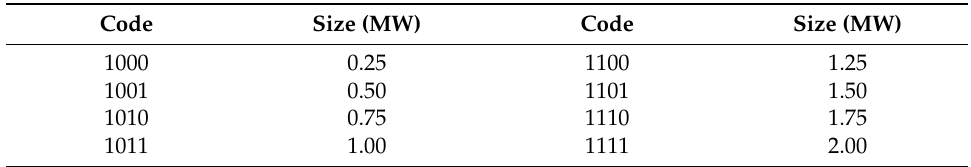
Table 1. Codification of Distribution Generation (DG) size.